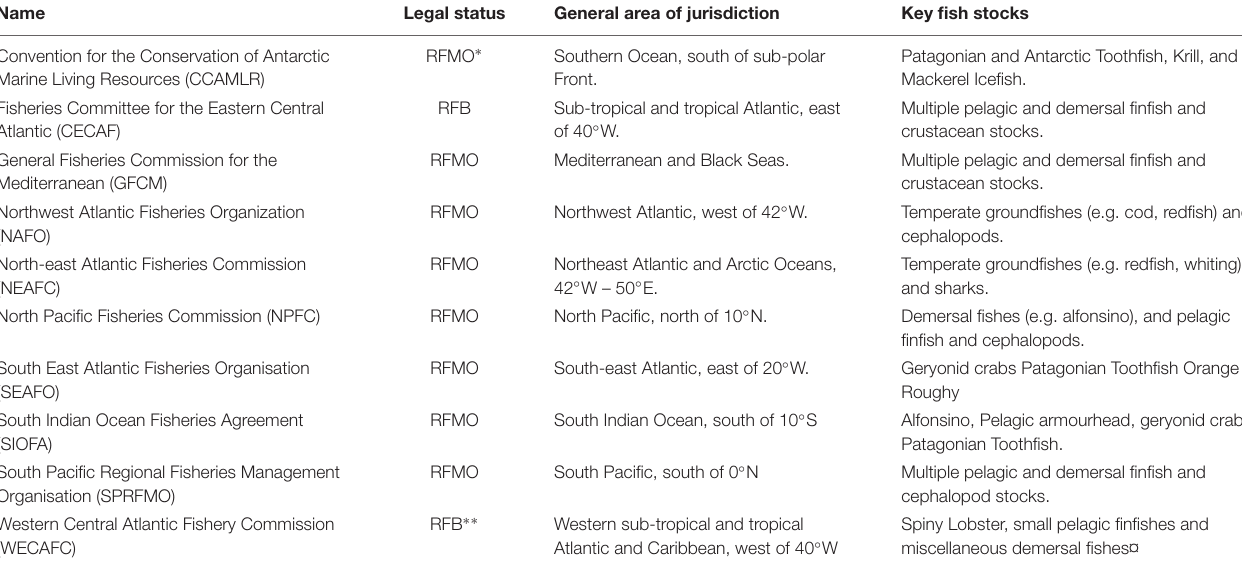
TABLE 1 | Organizations reviewed in this article. RFMO waters, except GFCM, are only in ABNJ. RFB waters include territorial seas ( Figure 1